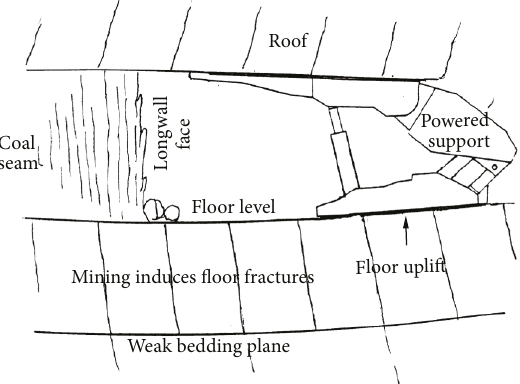
Figure 9: Primary failure-induced blocks in the fl oor and interaction with fl oor uplift to produce secondary failure